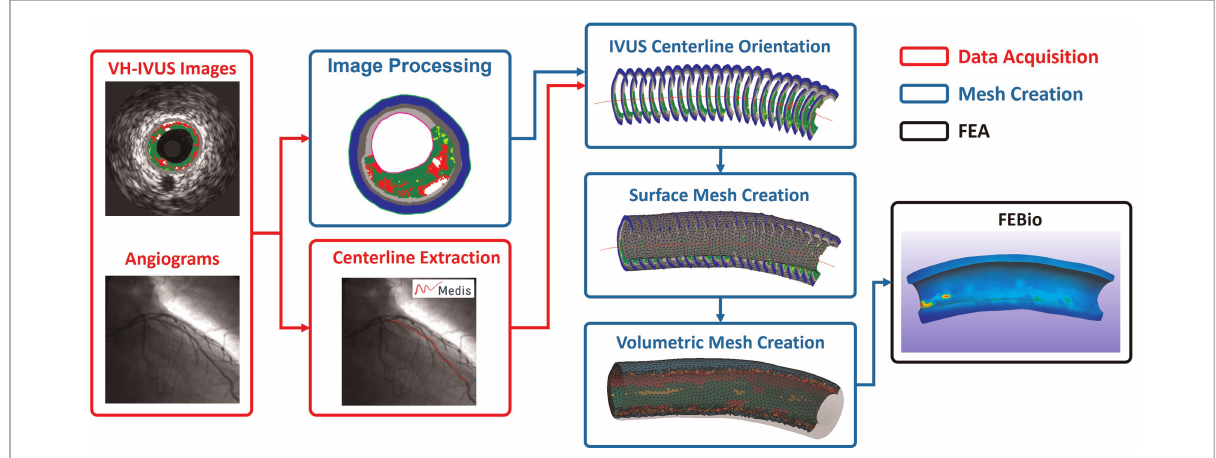
FIGURE 1 Simpli fi ed work fl ow highlighting the steps in creating a patient-speci fi c artery model with material properties. Artery centerline is extracted from angiogram data (Red). VH-IVUS images are processed to extract individual plaque constituent data, oriented along the 3D centerline, and meshed to create the volumetric fi nite elements (Blue). FE analysis is solved in FEBio